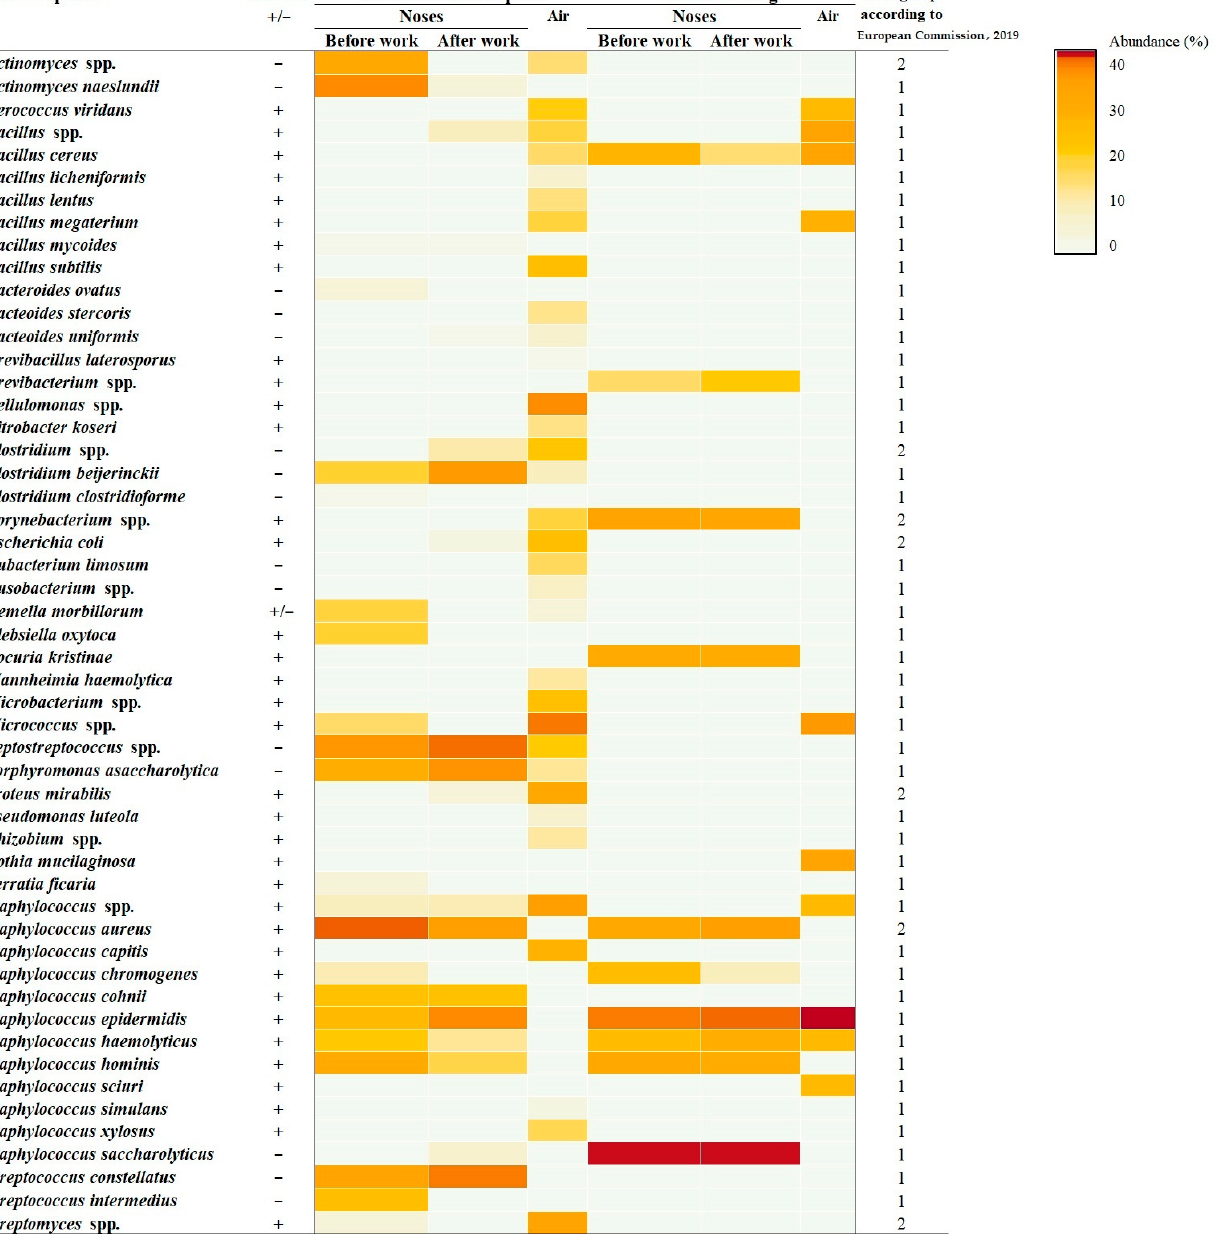
Figure 1. Qualitative characteristics of airborne bacteria identified in the worksites under study [29].